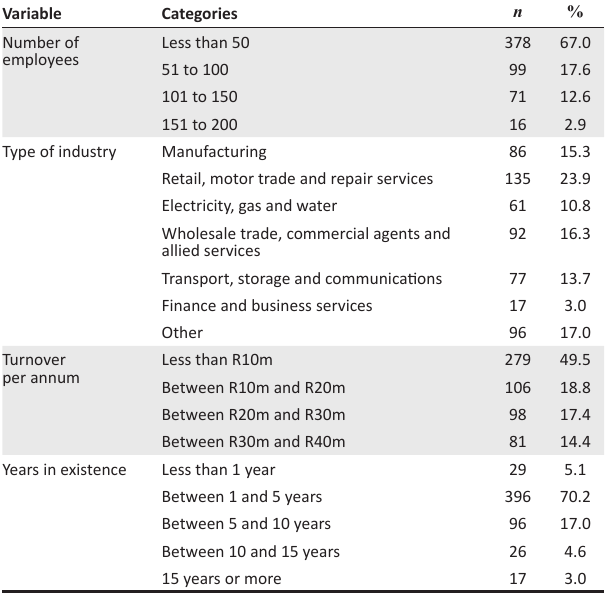
TABLE 1: Profile of participating small to medium enterprises.